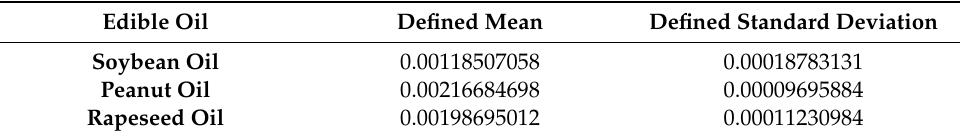
Table 3. The fixed mean and fixed standard deviation obtained by the training sets of three frying